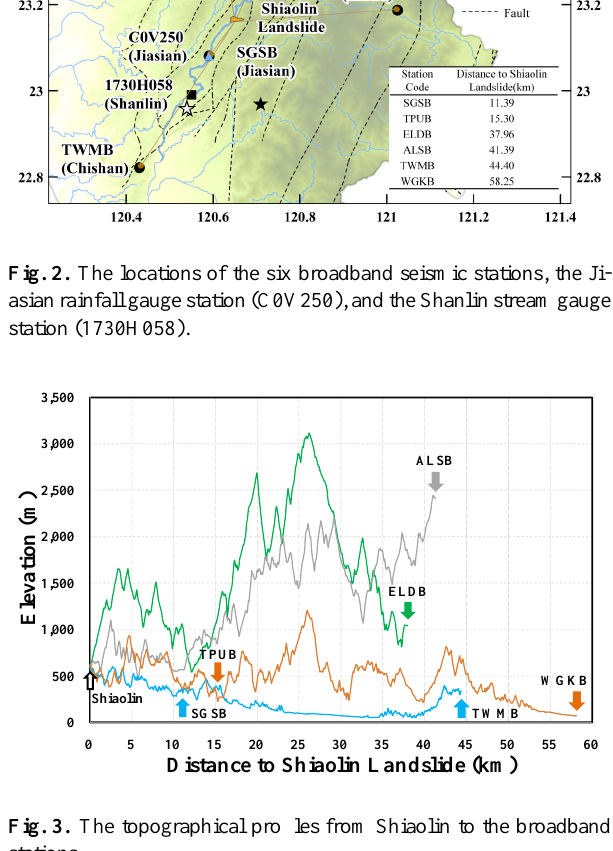
Figure 3 The topographical profiles from Shiaolin to the broadband stations. Fig. 3. The topographical profiles from Shiaolin to the broadband stations.